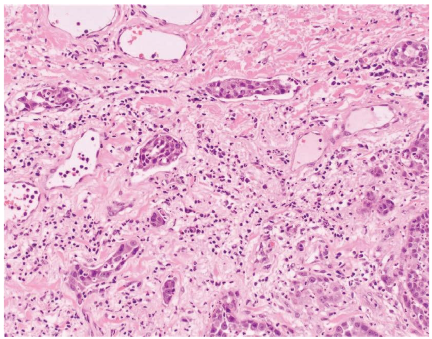
Figure 3: SC with lymphatic